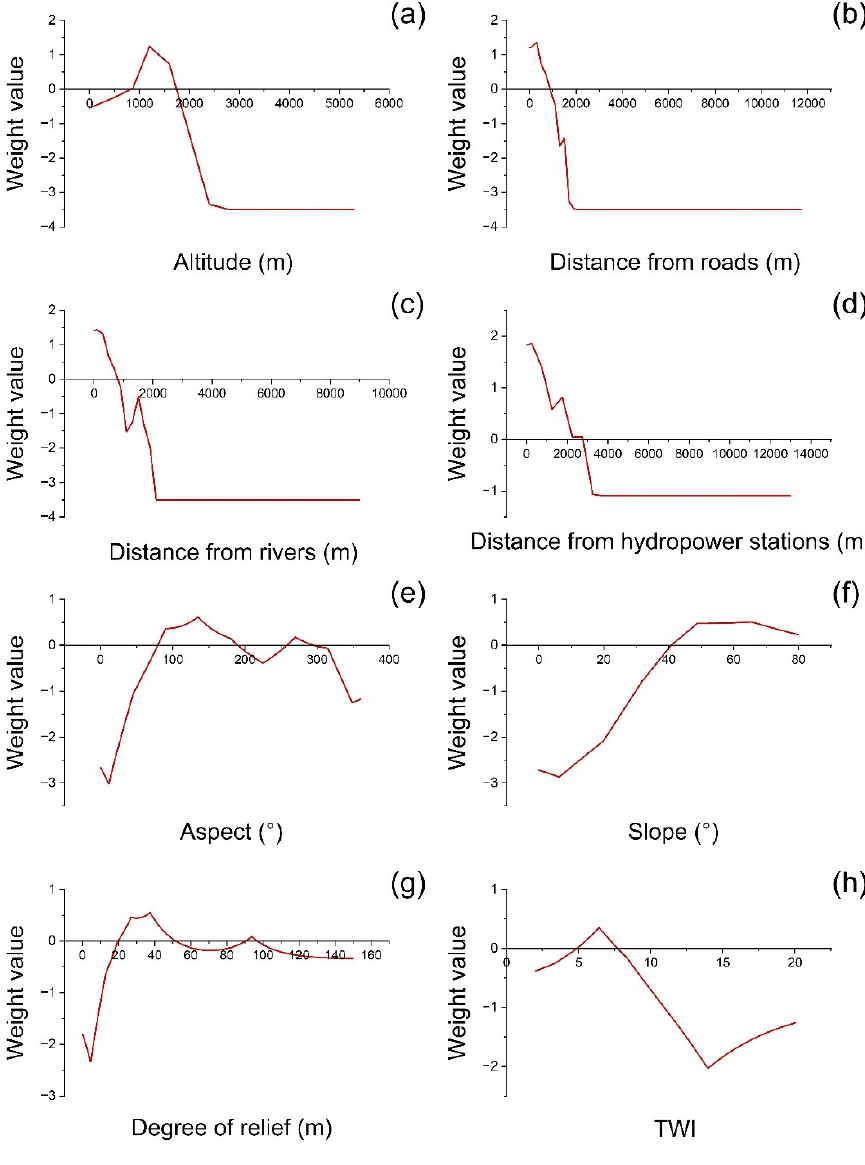
Figure 8. Results of weight regression using Gaussian process regression algorithm: ( a ) distance from roads; ( b ) distance from main rivers; ( c ) altitude; ( d ) distance from hydropower stations; ( e ) aspect; ( f ) slope; ( g ) degree of relief; ( h ) TWI.